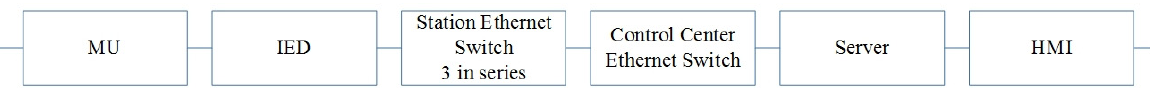
Figure 3. The RBD for the cascading